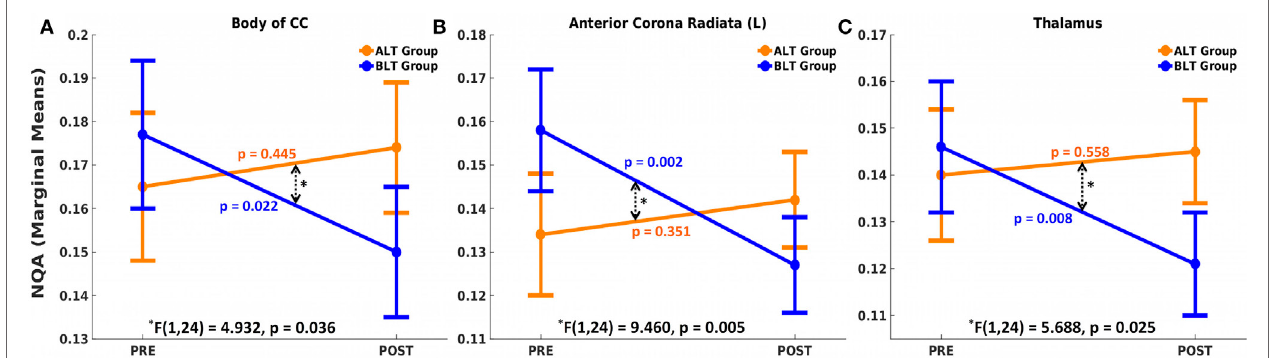
**Mean difference between post- and pre-treatment is significant at p < 0.05.